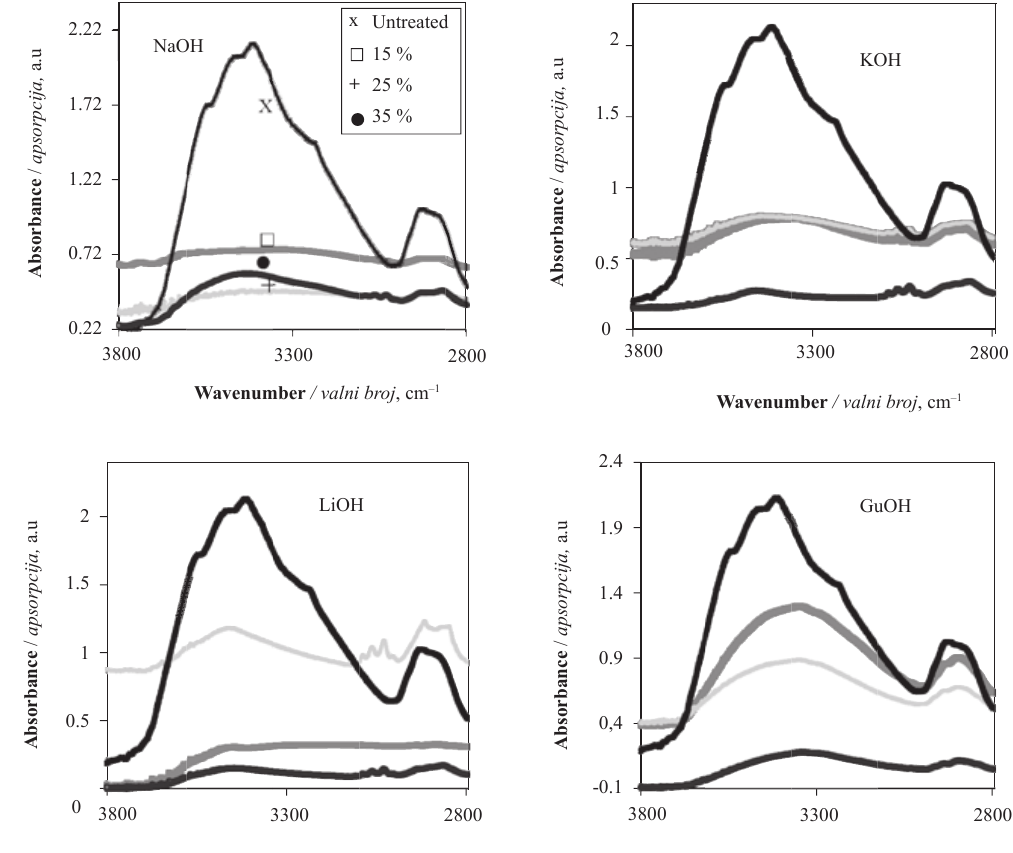
Figure 3 Aromatic stretch at 3030 - 3050 cm -1 due to monosubstituted benzyl rings Slika 3 . Aromatski dio na 3030 – 3050 cm -1 zbog monosupstitucije benzilskih